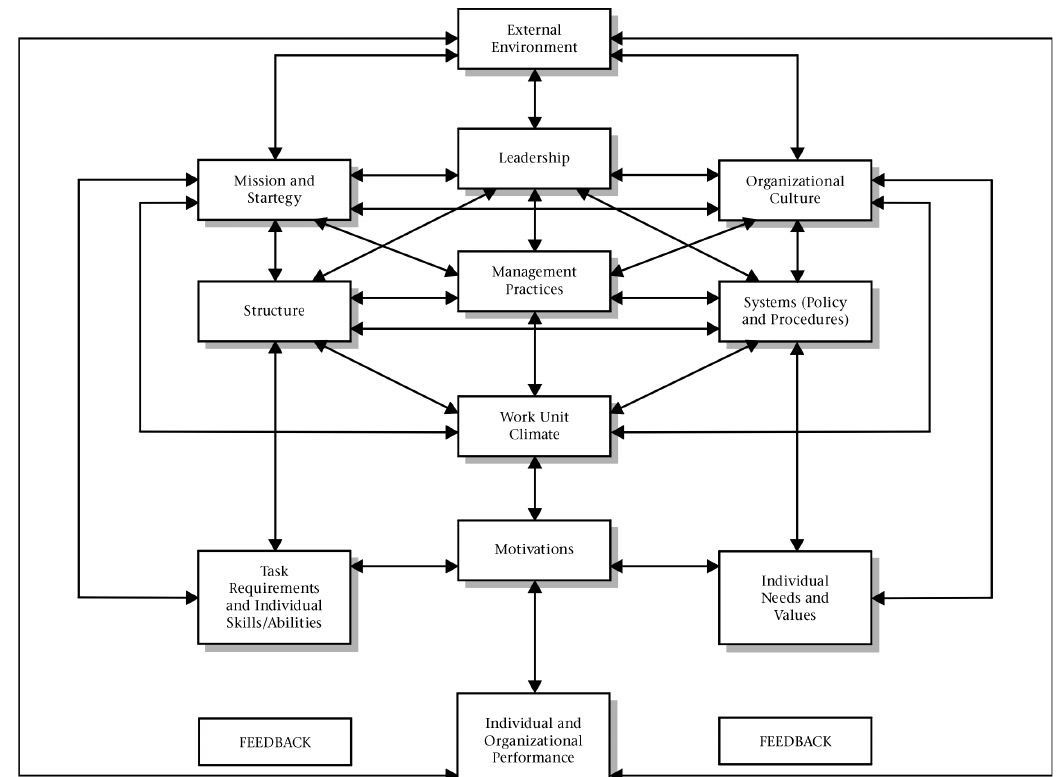
Figure 1: Burke and Litwin (1992) model for organizational performance and